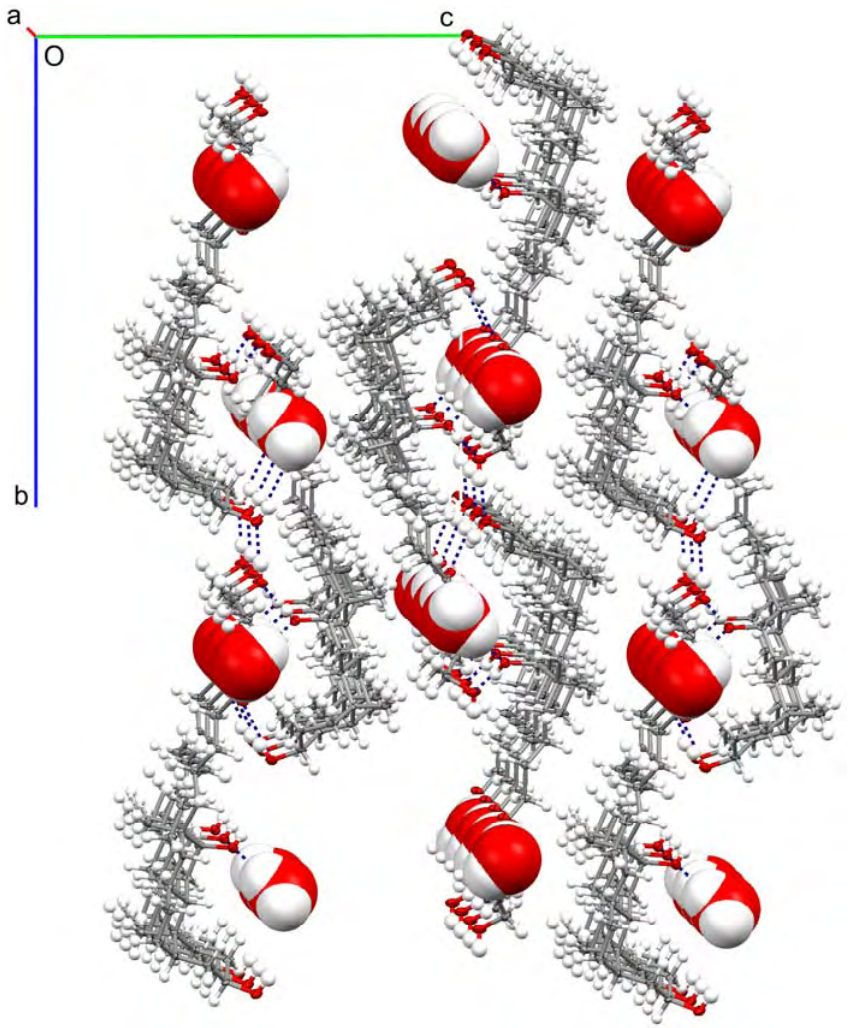
O molecules is 2